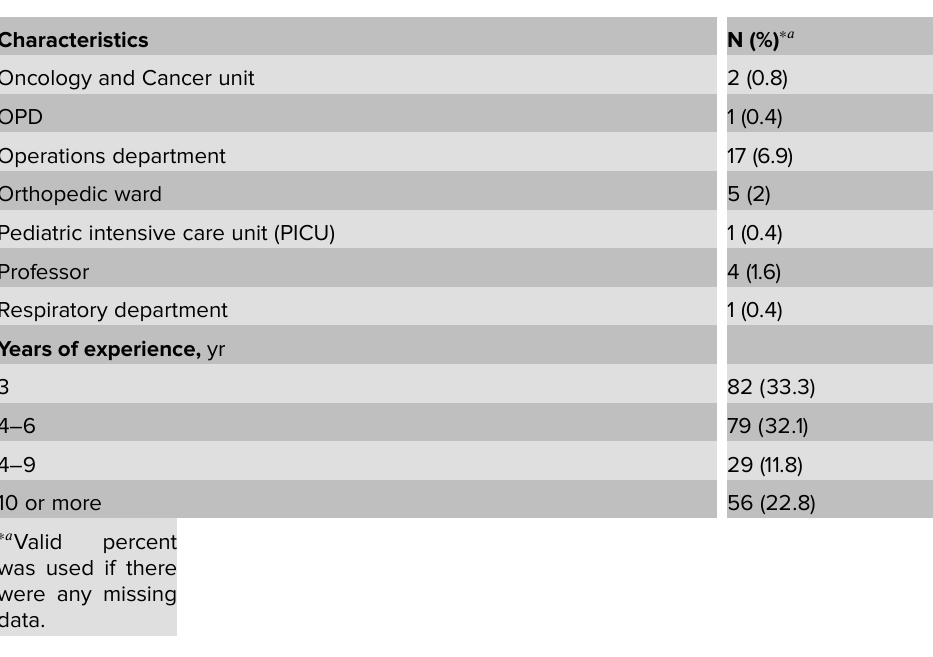
Table 1: General